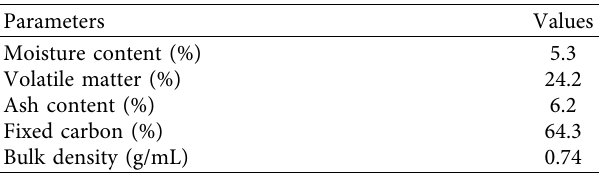
Table 4: Proximate analysis of the